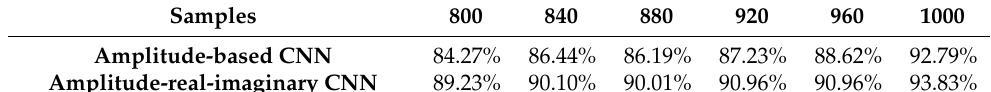
Table 9. Classification accuracy based on different networks under EOC.